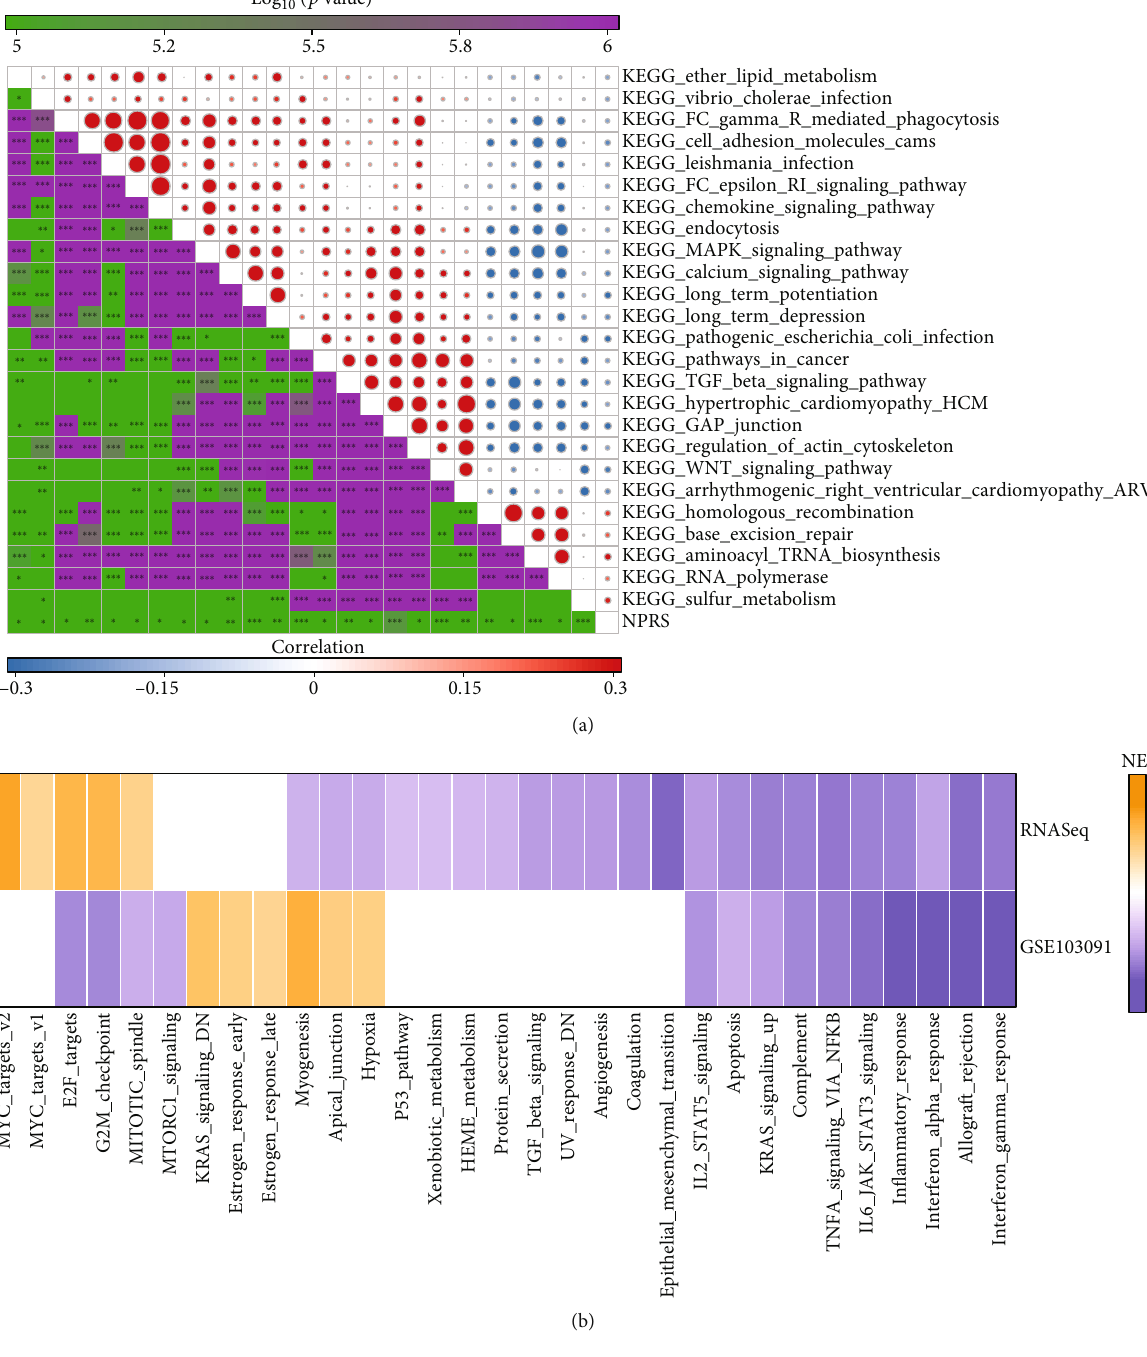
Figure 7: Pathway di ff erence analysis of NPRS groups in RNAseq queue. (a) The results of correlation analysis between KEGG pathway and NPRS whose correlation with NPRS is greater than 0.2. (b) Heatmap depicting the normalized enrichment scores (NESs) of the Hallmark pathways that were estimated after comparing the NPRS-high with the NPRS-low (at the false discovery rate ð FDR Þ < 0 : 05 ). ns: no signi fi cance. ∗ p < 0 : 05 , ∗∗ p < 0 : 01 , ∗∗∗ p < 0 : 001 , and ∗∗∗∗ p < 0 : 0001